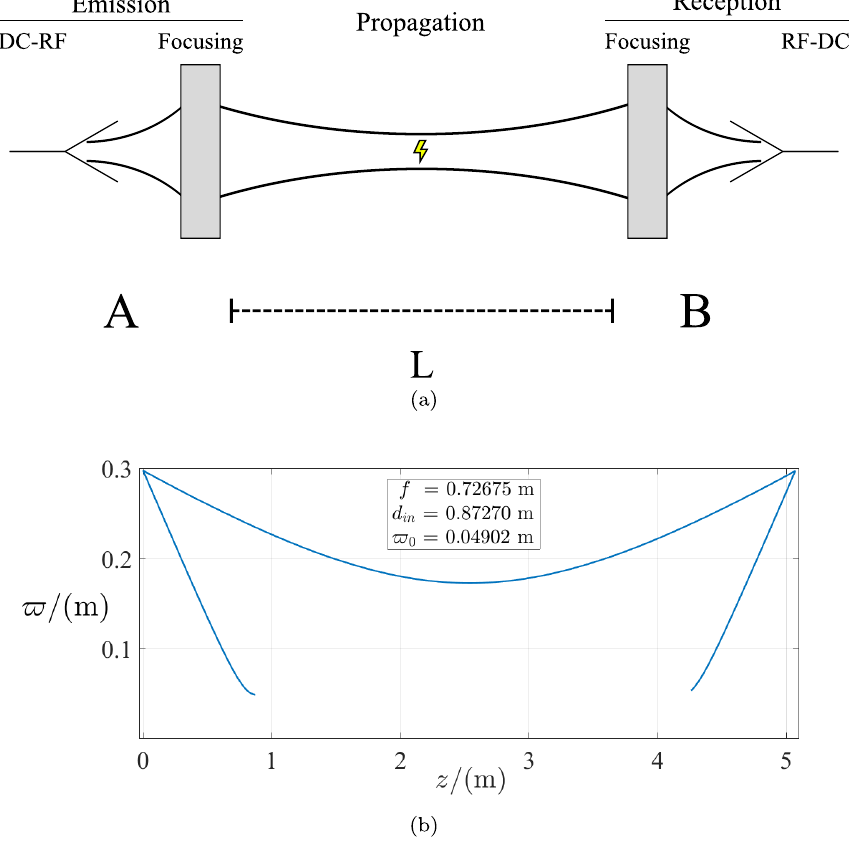
Figure 1. ( a ) Generic quasioptical wireless power transfer system overview. ( b ) Representation of the gaussian beam radius throughout the complete system.